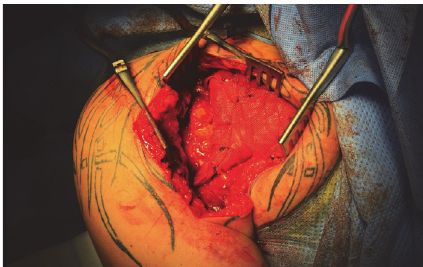
Figure 6: Intraoperative photograph with Vicryl plate wrapped around the